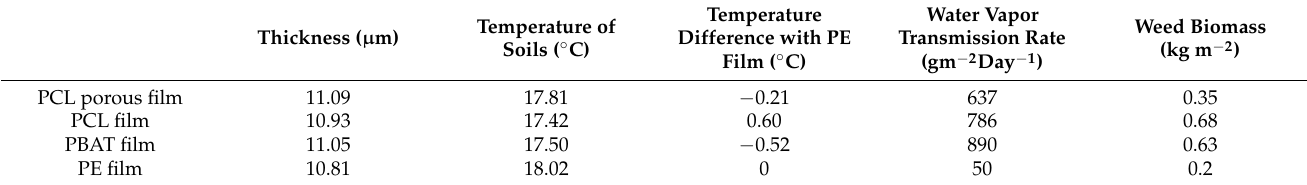
Table 1. Functional performance for different mulching